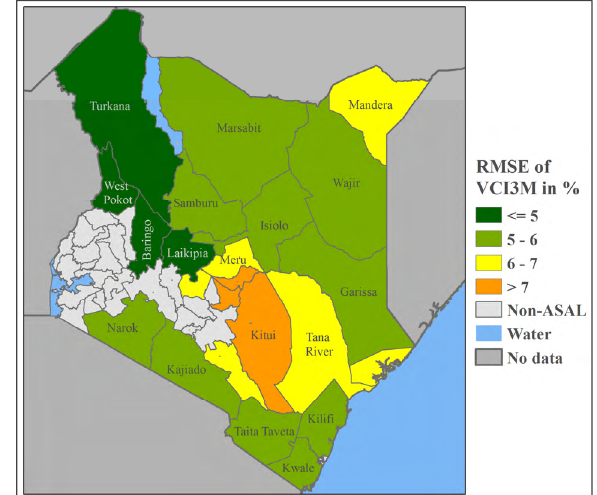
Figure 5: Intra-annual agreement/disagreement between monthly updated FEWS NET and BOKU VCI3M values. (green) coefficient of determination (R²), (blue) root mean Figure 7: Variations of root mean square error (RMSE) between square error (RMSE) between the two data sets. In (orange) monthly FEWS NET and BOKU VCI3M values for ASAL time course of the average NDVI of ASAL counties. Lines are counties. Counties outside the ASAL area are shown in grey. only shown for reader's convenience The observed minimum RMSE was 4.3 and the maximum